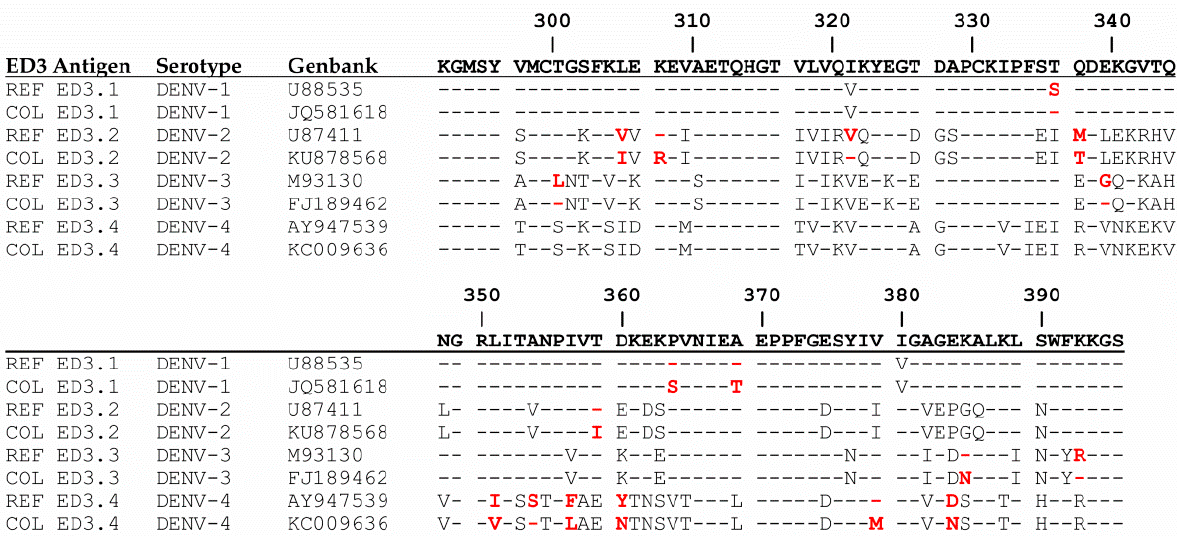
Figure 3. ED3 amino acid sequences used for ED3 ELISA and ED3 dot assay. Sequence differences between the same serotype are marked in red. Amino acid differences between REF:COL for DENV-1, S339T, P364S, A369T; for DENV-2, V308I, I310R, V324I, M340T, T359I; for DENV-3, L303T, G342E, K385N, R393K; for DENV-4, I351V, F357L, Y360N, V379M, D384N.